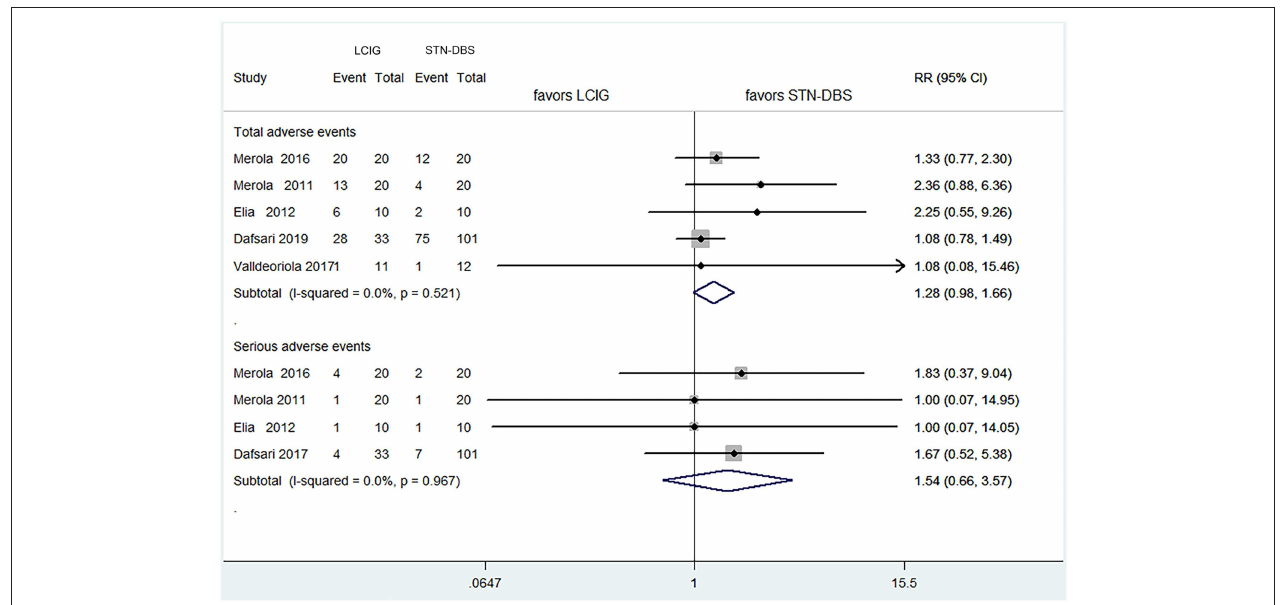
FIGURE 3 | Comparisons between LCIG and STN-DBS for adverse events. LCIG, Levodopa/carbidopa intestinal gel infusion; STN-DBS, Subthalamic nucleus deep brain